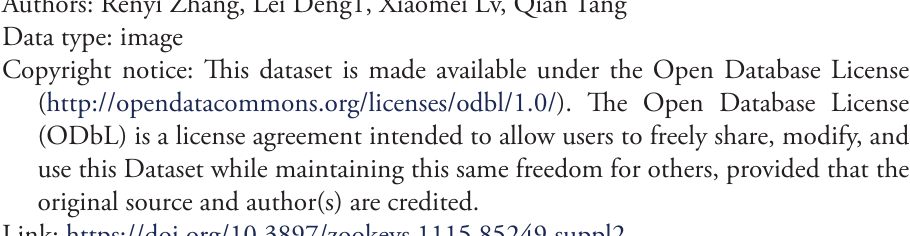
Table S1. Primers used for